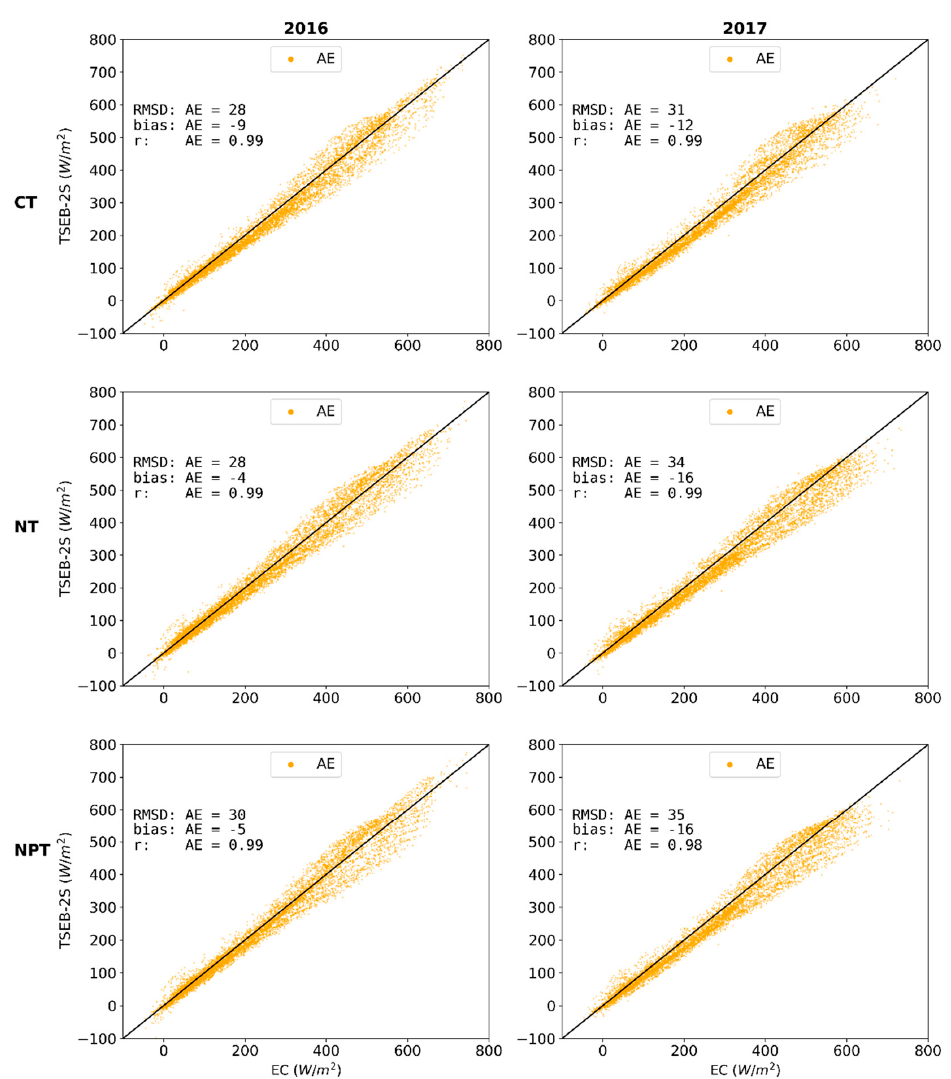
Figure A2. Grass, tree, and ecosystem LAI time series for the CT tower for 2015. Note that tree LAI shown here refers to the effective (landscape) LAI, meaning that the tree ‐ based measurement was weighted by its fractional cover (i.e., 0.2).